Question: Summarize what this figure shows in one sentence.
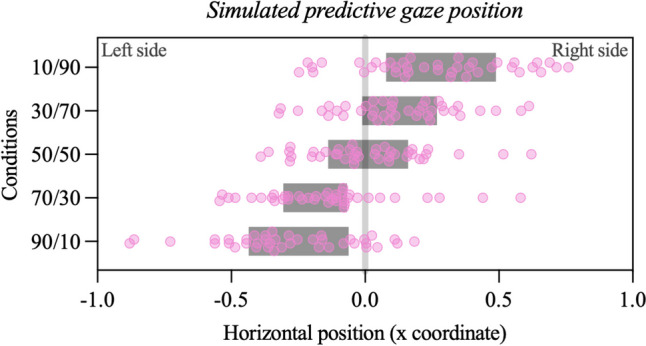
Answer: Model-based simulations of predictive gaze behaviour in the experimental task. Note: To help motivate our hypotheses and determine exactly the behaviour that a Bayes-optimal observer would display in this task, we ran a series of simulations using a model of Bayesian inference (the hierarchical Gaussian filter (Mathys et al., 2011 , 2014 ), described in detail in the ‘ Methods ’ section). We provided 40 simulated observers with the exact trial order used in the study and recorded their trial-by-trial responses. We allowed a degree of randomness/noise in the responses of the simulated agents to provide some variance in the data, but even so these simulated responses are likely to be less variable than real eye movements. The simulations provided a clear demonstration that for Bayes-optimal observers, mean gaze position would be more extreme under increasingly biased conditions. Grey boxplots indicate the interquartile range, with overlaid data points. Full details of the modelling approach and the MATLAB code are provided in the supplementary files ( https://osf.io/cjkz7 )